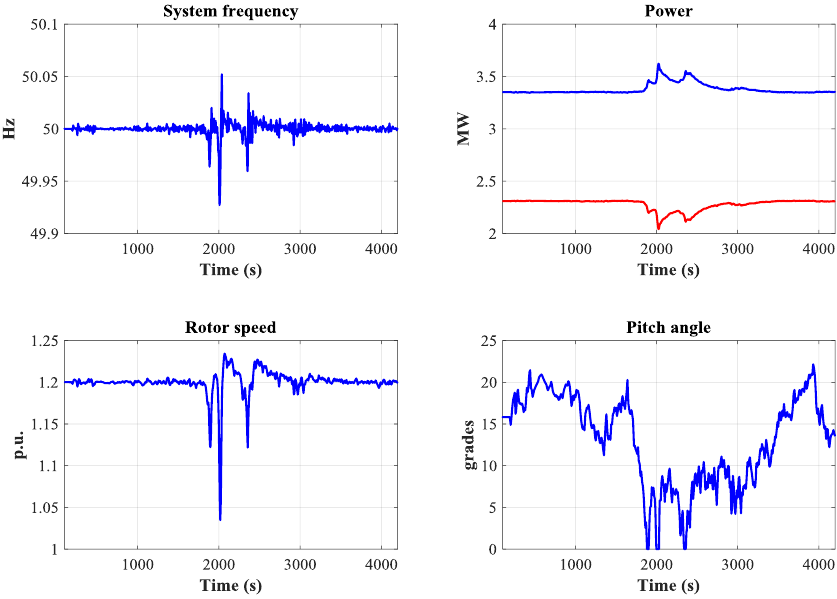
Figure A2. Dynamic responses of the system in case C during wind speed fluctuation.